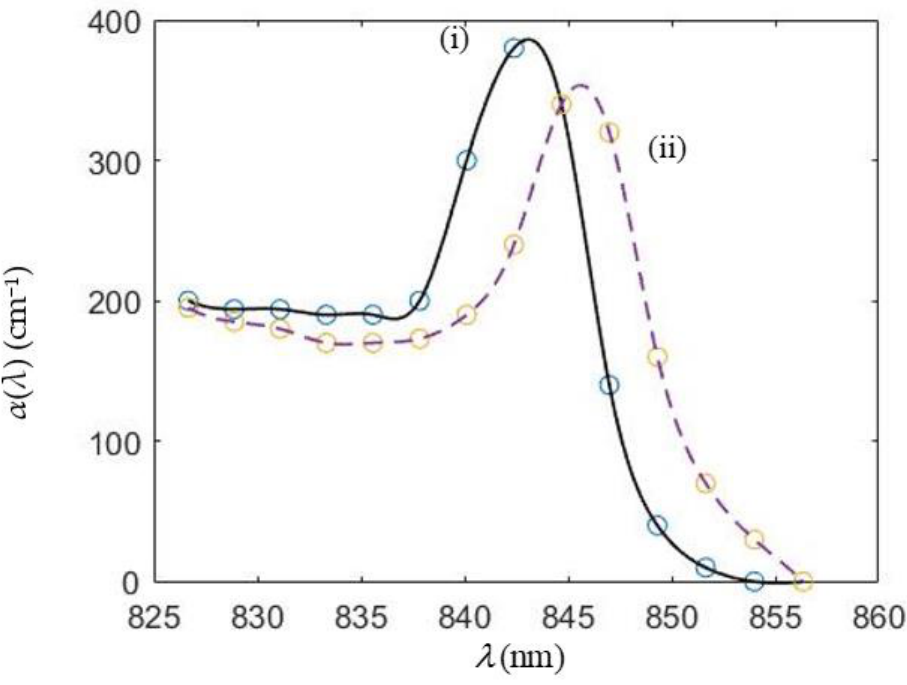
Figure 3. The absorption spectra α ( λ ) of the quantum well waveguide for the s-polarization mode as a function of the electric field applied perpendicular to the layers. (i) 1.6 × 10 4 V/cm and (ii) 10 5 V/cm [20]. The solid line and dashed line correspond to the two applied voltage values respectively. The circle markers on the lines are used for cubic spline interpolation.